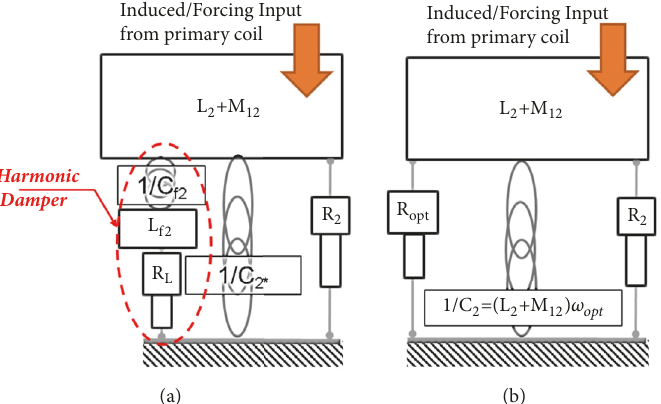
Figure 14: Equivalent 2DOF model of the secondary pad of the LCC compensation (a) and series-series circuit that has to be emulated (b).